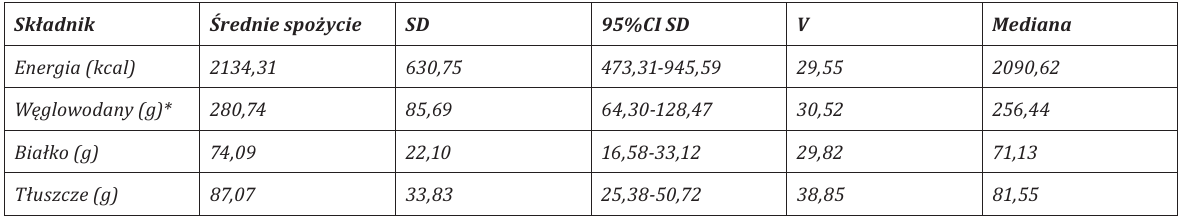
Tabela 4. Wartość energetyczna i zawartość makroskładników w dietach